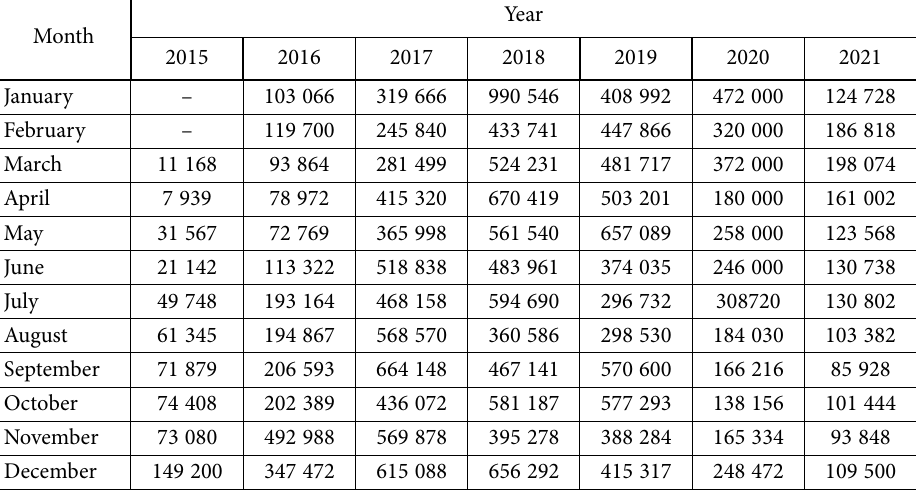
Table 2. The volume of turnover generated in the system between 2015 and 2021 (in Zielony) (source: own elaboration based on Stępnicka et al., 2021; data obtained from the administrator of the Zielony complementary currency system in